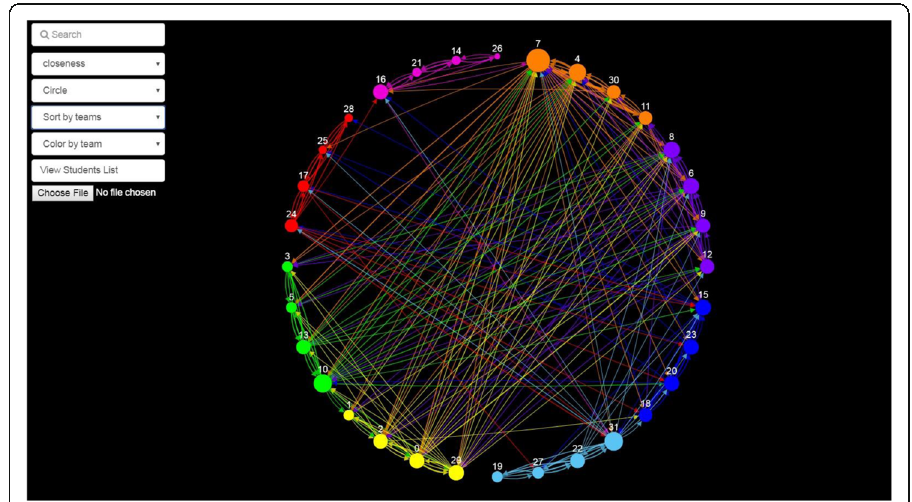
Fig. 6 Visualization provided by StudentViz using Circular layout. Nodes ’ diameters are proportional to PageRank metric, while their colors depict affiliation to a specific team. Through this image, the instructor can observe the status of each team in relation with other teams, as well as the status of each learner